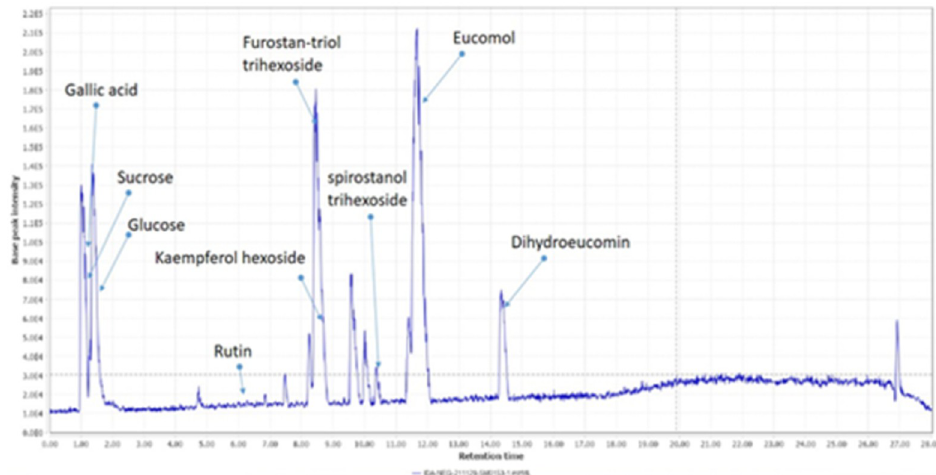
Fig 2. BPC of Yucca aloifolia fruit extract in negative ion mode.